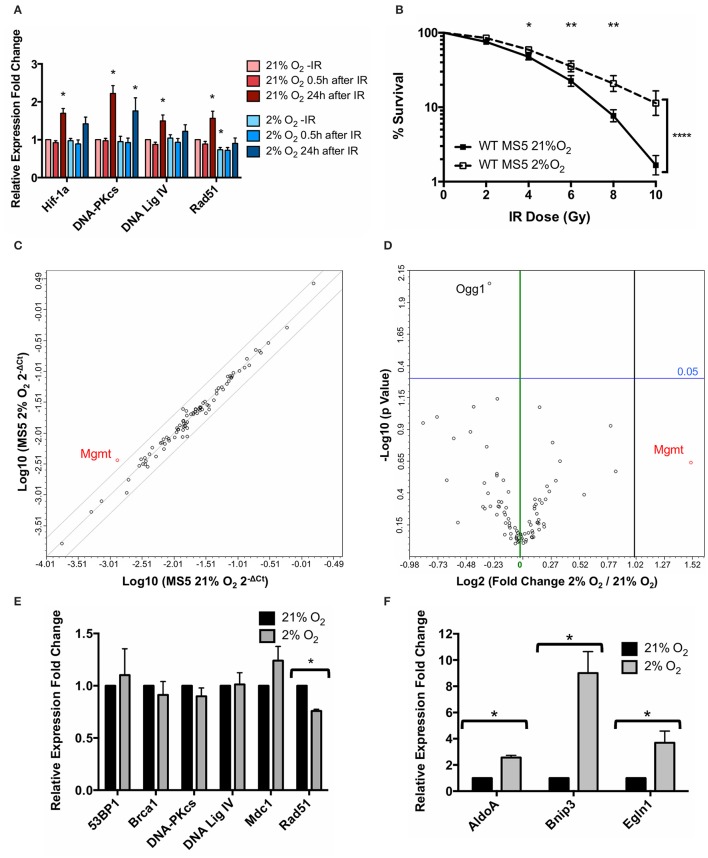
Hypoxia treatment does not affect mRNA expression of DNA Damage Response genes. (A) mRNA expression levels of Hif1a and the DDR factors DNA-PKcs (Prkdc), DNA Ligase IV (Lig4), and Rad51, measured 0–24 h after treatment with 10Gy IR. β-actin (Actb) was used as housekeeping gene and normoxic samples as reference for mRNA relative expression quantification using the ΔΔCt method. *p < 0.05, paired t-tests, n = 9. (B) Clonogenic survival assay of MS5 cells in 21 or 2% O2. *p < 0.05, **p < 0.01, ****p < 0.0001, compared with normoxic samples, two-way ANOVA with Bonferroni post-test correction for the multiple comparisons, n = 9. (C) Scatter plot and (D) volcano plot of qPCR array data comparing normoxic (21% O2) and hypoxic (2% O2) MS5 cells. In the scatter plot, diagonal lines represent − 2, 0, and +2-fold changes, from left to right. In the volcano plot, green and black vertical lines represent 0 and 2-fold expression changes, respectively. Blue horizontal lines represent a p value of 0.05 (n = 3), with significantly regulated genes being shown above them. All genes up-regulated more than 2-fold are shown in red (independently of their statistical significance). mRNA expression levels of (E) DDR factors 53BP1 (Tp53bp1), Brca1, DNA-PKcs (Prkdc), DNA Ligase IV (Lig4), Mdc1 and Rad51 and (F) Hif-1α target genes AldoA, Bnip3, and Egln1 in hypoxia (2% O2) compared to normoxia (21% O2). β-actin (Actb) was used as housekeeping gene and normoxic samples as reference for mRNA relative expression quantification using the ΔΔCt method. *p < 0.05, paired t-tests, n = 4.